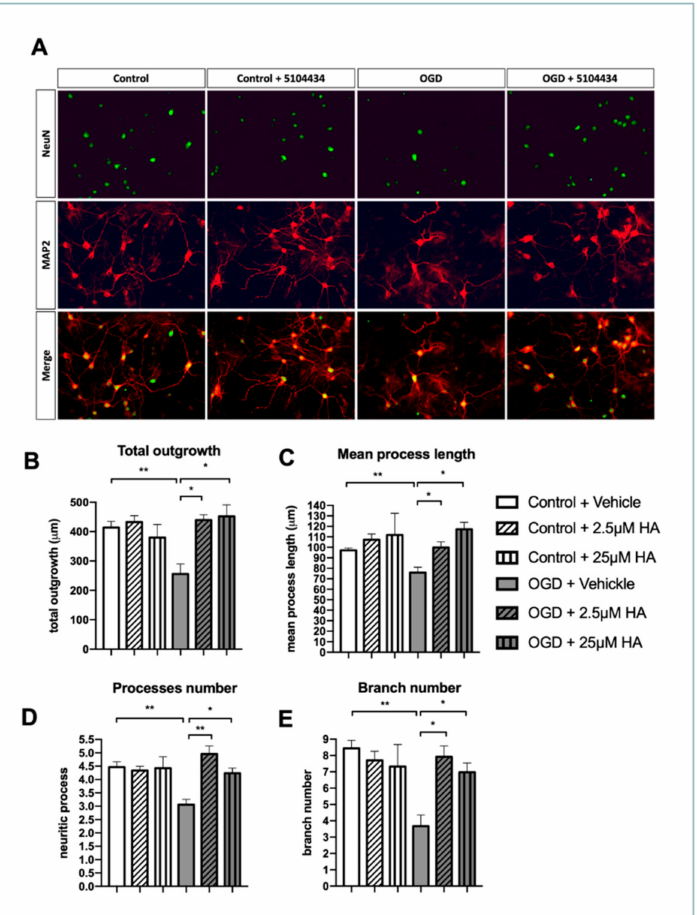
Figure 2. HA treatment preserved neurite outgrowth pattern in terms of total outgrowth, process length, process number, and branch number in vitro. ( A ) Representative figures of immunocyto- chemistry staining for NeuN and MAP2 in primary neuron 24 h after OGD. ( B – E ) High-throughput- acquired neuron images were analyzed in terms of total outgrowth, process length, process number, and branch number. n = 6. * Denotes p < 0.05, ** denotes p <